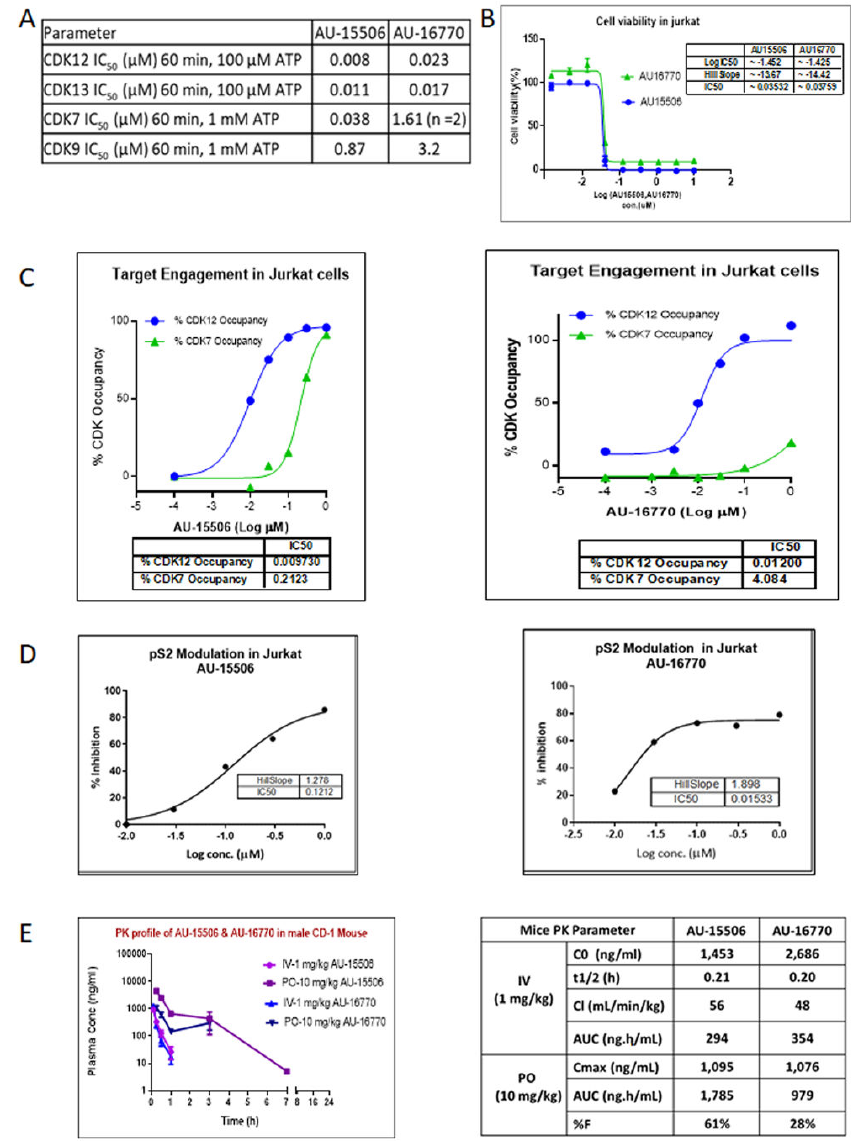
Figure 2. Characterization of lead compounds targeting CDKs. ( A ) In vitro profile of lead compounds AU-15506 and AU-16770. Kinase inhibition assay was performed with indicated kinases in presence of above CDK inhibitors. ( B ) Cell viability profile of lead compounds AU-15506 and AU-16770 in Jurkat cells. IC50s of these inhibitors are shown in the inset table. ( C ) Target engagement profile of lead compounds AU-15506 and AU-16770 in Jurkat cells. % CDK occupancy of the inhibitors increases with increasing concentration and IC50s of %CDK occupancy is shown in the bottom table. ( D ) Modulation of pS2 in Jurkat cells treated with lead compounds AU-15506 and AU-16770. ( E ) Pharmacokinetic profile of lead compounds. Mice were separately administered with AU-15506 and AU-16770 either by intravenous injection (IV) or by oral gavage (PO), and the pharmacokinetic parameters were measured at different time points as indicated. Abbreviations: C 0 , initial plasma concentration; T 1/2 , the mean terminal elimination half-time; CL, clearance; AUC, area under plasma concentration; C max , maximum plasma concentration; %F,